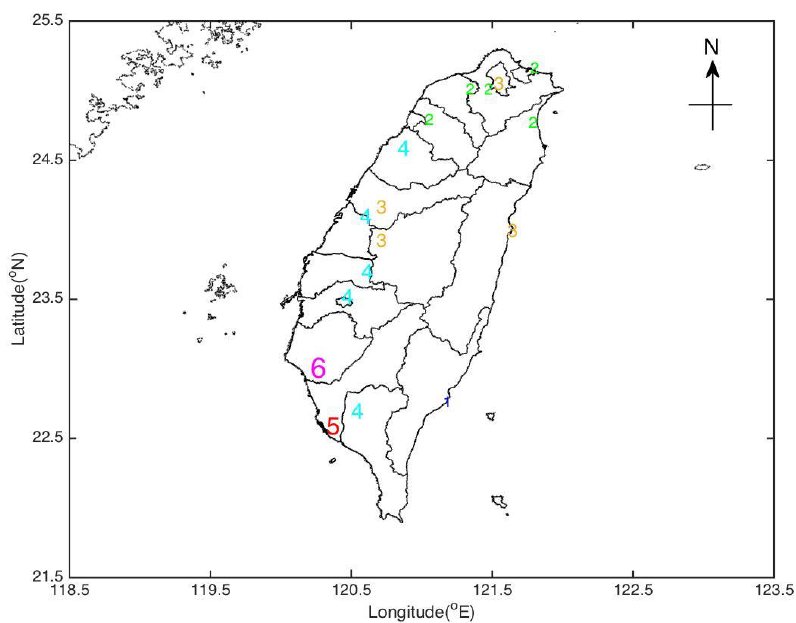
Figure 5. The intensity distribution analyzed by our approach for the earthquake occurring on 6 February 2016.